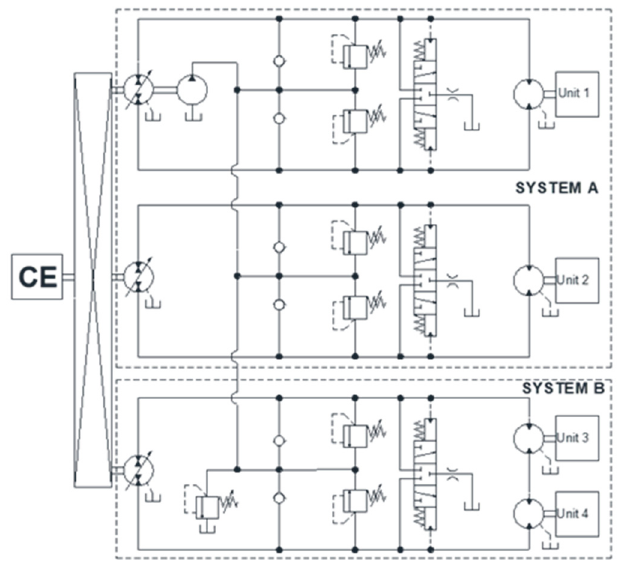
(25) Figure 8. Proposed split LP system with ASPU valve. 3. Reference System